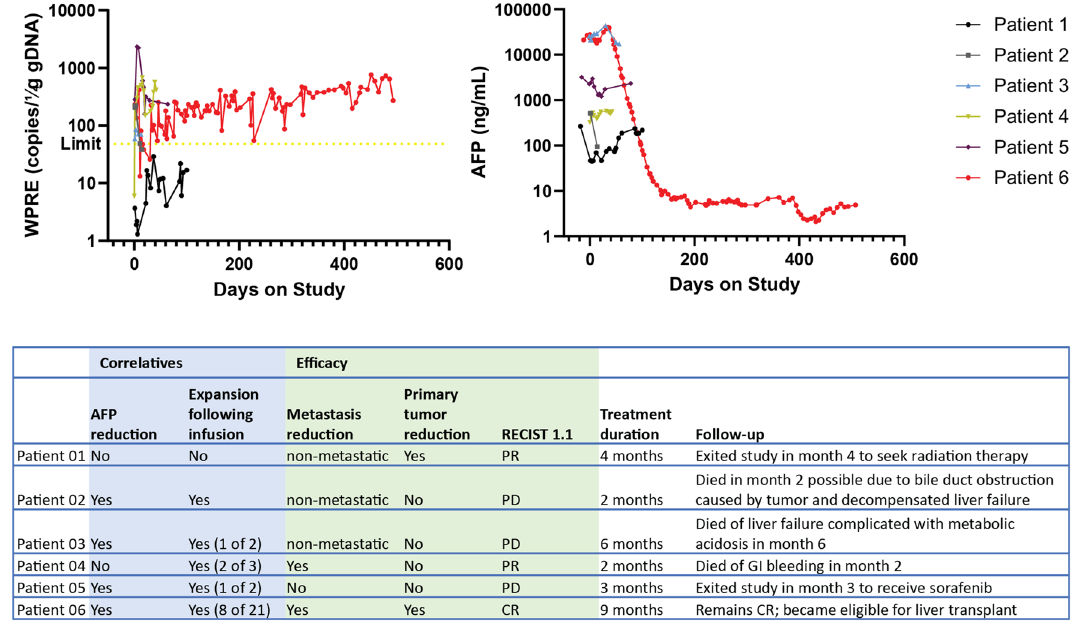
Figure 4. AbTCR + co-stim receptor-positive cells can expand after infusion, reduce serum AFP levels and cause HCC tumors to regress. Each patient was assayed for vector WPRE expression by PCR analysis and serum AFP level by ELISA the day after infusion. The detection limit for the PCR is shown; each value for the clinical- grade AFP ELISA is within range of the assay. The table summarizes the correlative relationships between receptor-positive T cell expansion and AFP reduction on an infusion-by-infusion basis. Efficacy is summarized in terms of regression observed and RECIST1.1 score at the conclusion of